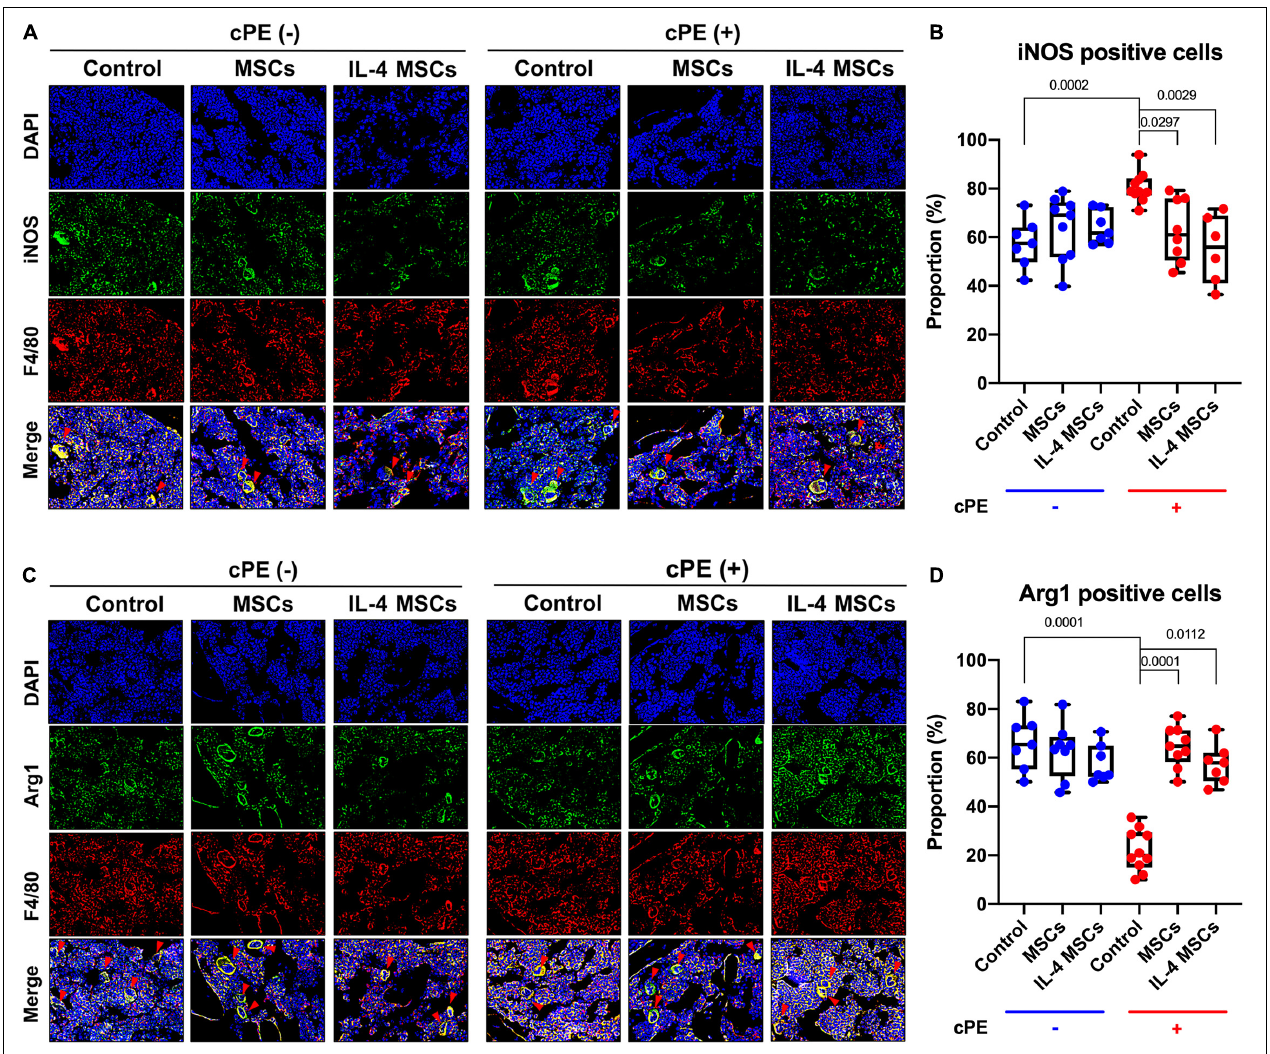
FIGURE 4 | Immunohistochemistry and quantitative analysis for M1 and M2 macrophages in all groups. (A) Representative images of immunohistochemistry for M1 macrophages (iNOS + , F4/80 + , red arrows). (B) Quantitative analysis for iNOS positive cell proportion (cPE- control group: n = 7; cPE- MSCs group: n = 9; cPE- IL-4 MSCs group: n = 7; cPE + control group: n = 10; cPE + MSCs group: n = 8; cPE + IL-4 MSCs group: n = 6). (C) Representative images of immunohistochemistry for M2 macrophages (Arg1 + , F4/80 + red arrows). (D) Quantitative analysis for Arg1 positive cell proportion (cPE- control group: n = 7; cPE- MSCs group: n = 8; cPE- IL-4 MSCs group: n = 7; cPE + control group: n = 10; cPE + MSCs group: n = 9; cPE + IL-4 MSCs group: n =